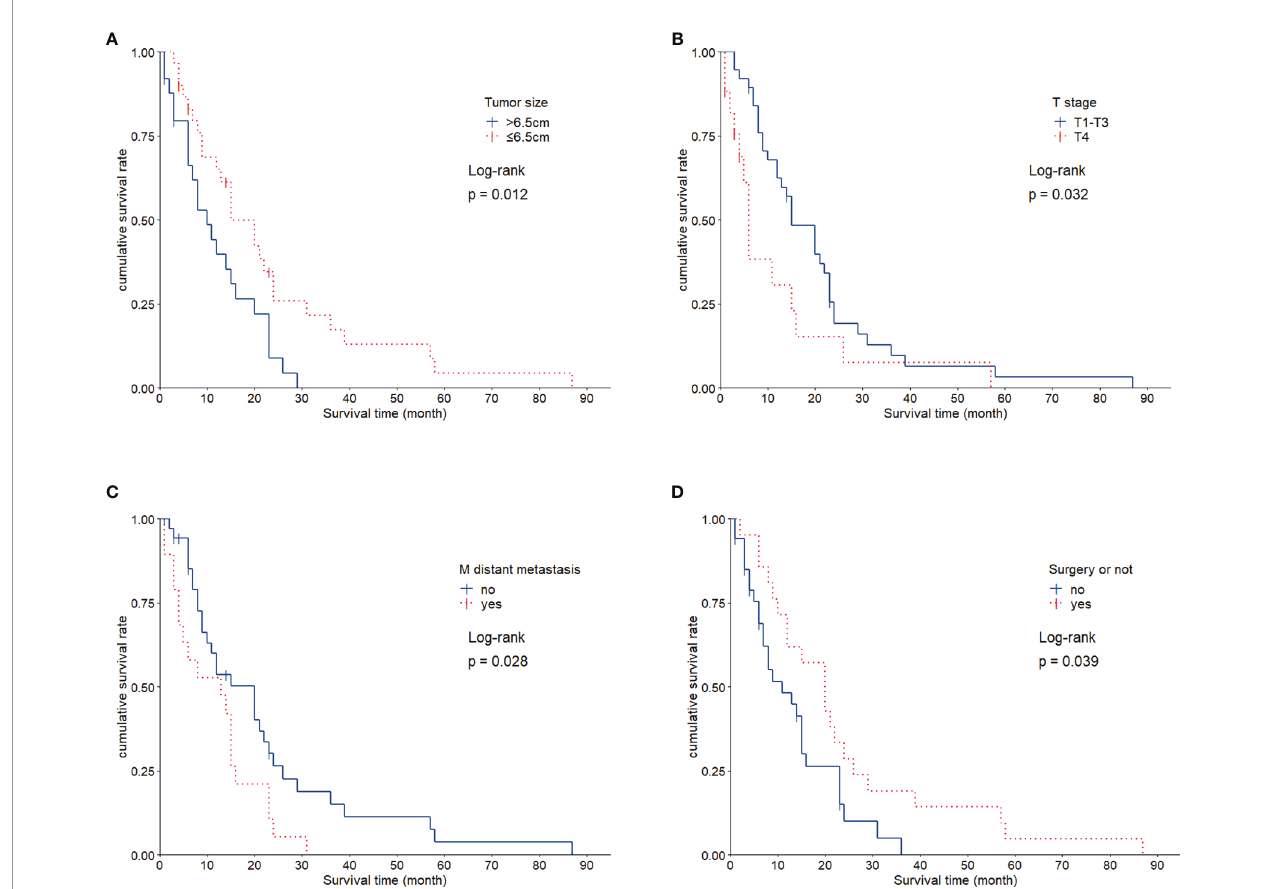
FIGURE 3 | Kaplan-Meier Survival Curves for Each Factor. (A) , Patients with small tumor size ( ≤ 6.5 cm) exhibited signi fi cantly longer survival than did patients with larger tumors ( p = 0.012). (B) , Statistically signi fi cant difference in survival between individuals with T1+3 and T4 ( p = 0.032). (C) , Survival was signi fi cantly different based on M stage ( p = 0.028). (D) , Patients showed signi fi cant differences in survival as related to surgical treatment ( p =